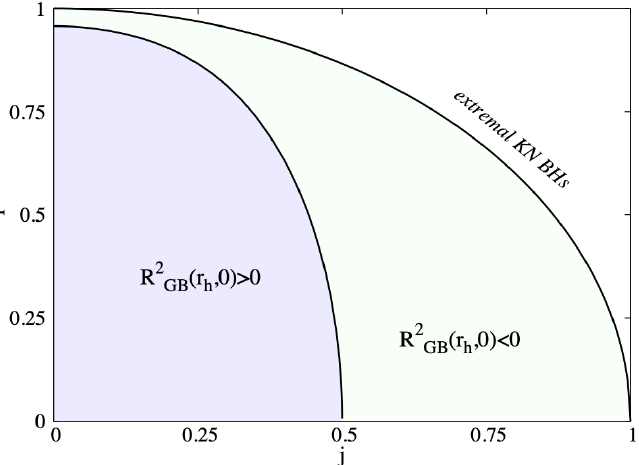
Figure 1. GB invariant (in units of mass) of a Kerr-Newman BH with mass M , angular momentum J and charge Q , evaluated at the horizon’s poles ( r = r h and θ = 0), as a function of the dimensionless parameters j = J / M 2 and q = Q / M . Near extremality, R 2